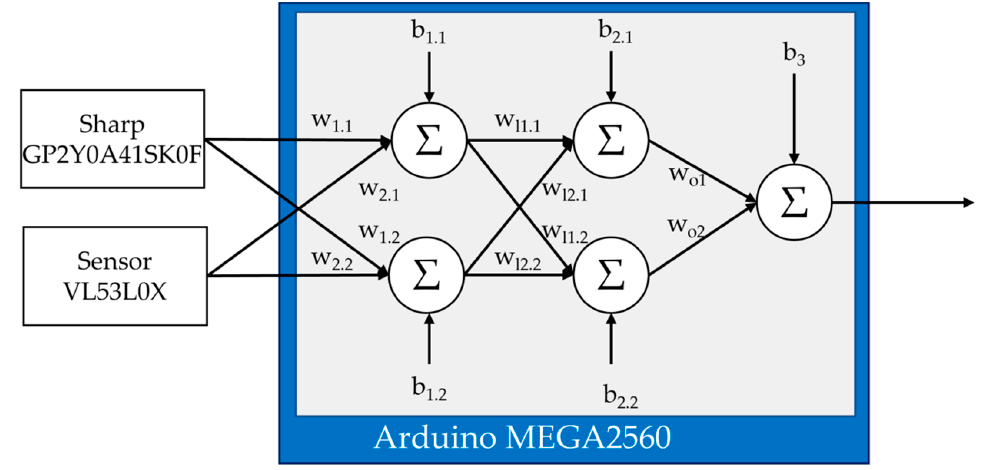
Figure 4. The structure of the neural distance